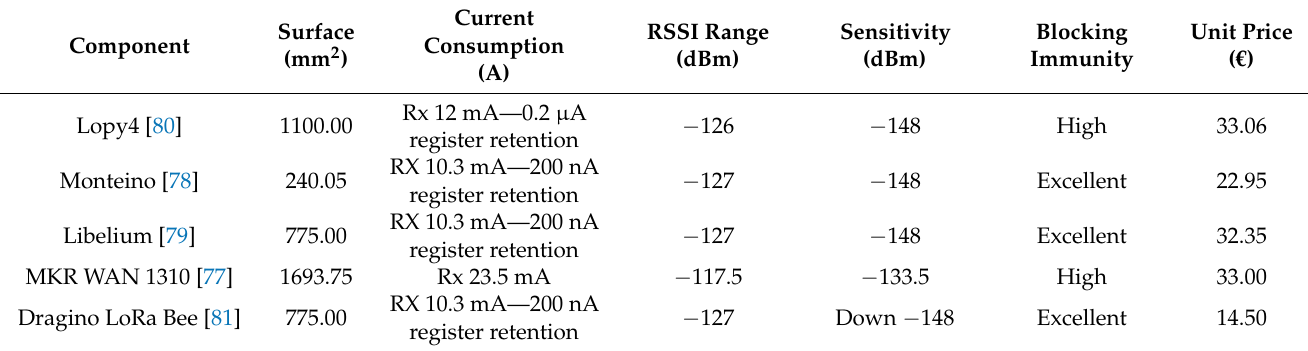
Table 3. LoRa end-devices